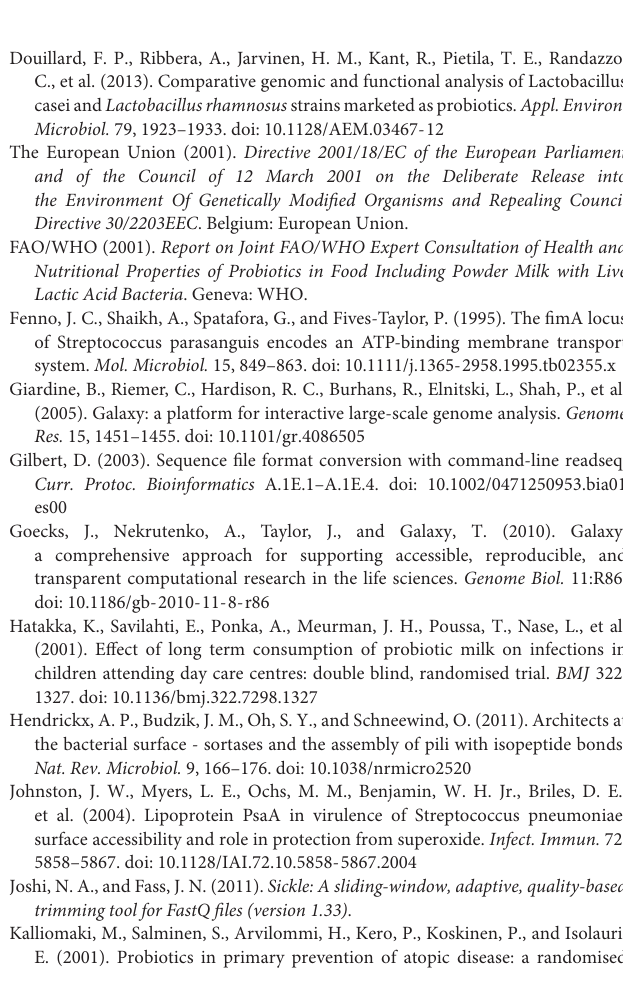
FILE S1 | SNPs identified by shotgun Illumina sequencing in all highly adherent derivatives. Includes an SNP comparison sheet where similar SNPs in genes and intergenic regions between all selected derivatives are highlighted: green for the ones shared amongst all highly adherent derivatives and blue for the SNPs common amongst all Class I